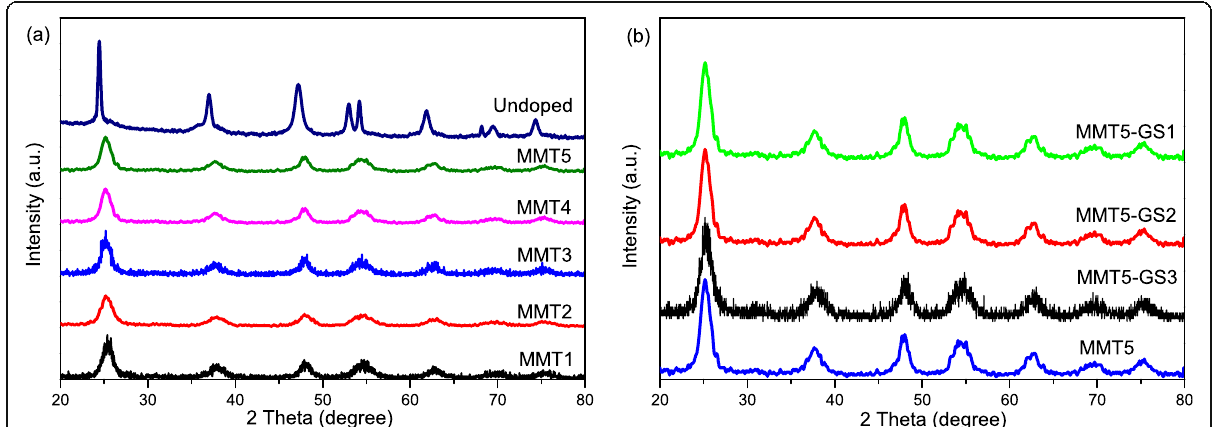
Fig. 2 a XRD patterns of undoped TiO 2 and Mn 2+ /Mg 2+ bimetal doped TiO 2 (MMT1-MMT5) catalysts, b MMT5 and surfactant assisted catalysts (MMT5-GS1-